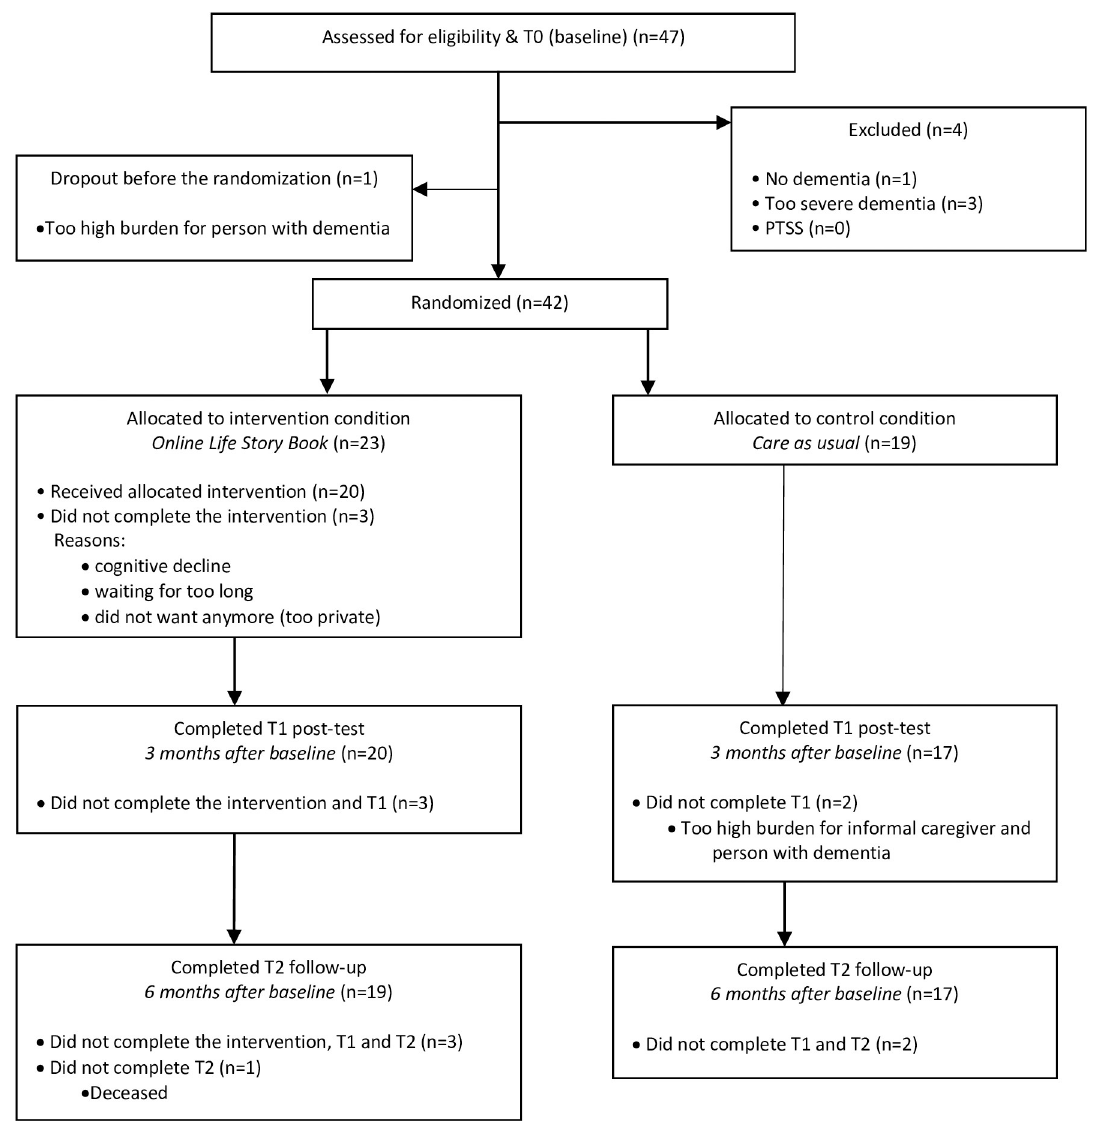
Fig 1. Participant